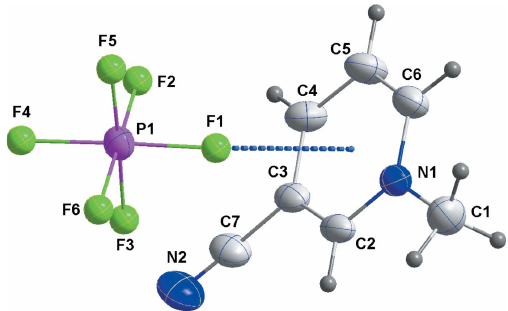
Figure 2 Perspective view of 2 with labeling scheme and 50% probability ellipsoids. Only the major orientation of the disordered anion is shown. The cation–anion interaction is indicated by a dashed line.